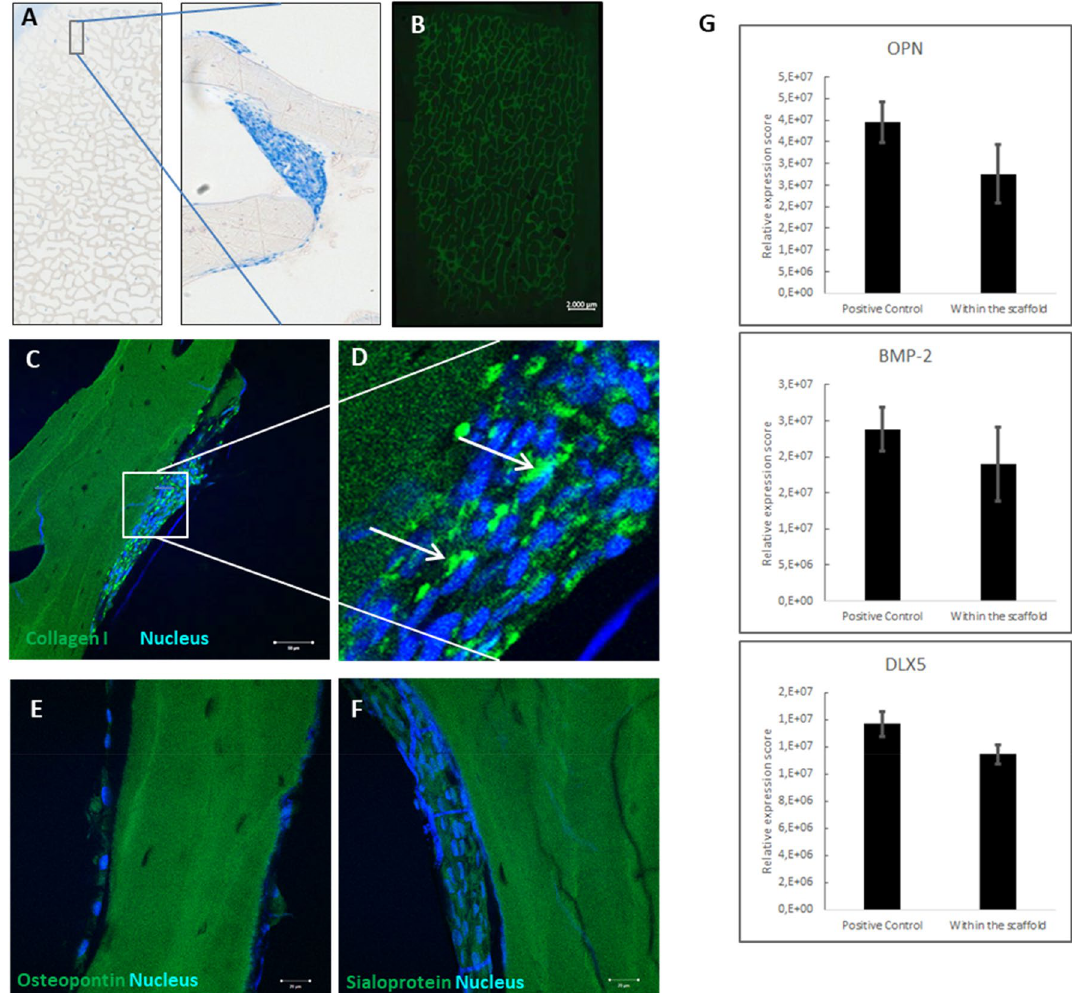
Figure 8. Histological analysis of scaffolds perfused with oscillating perfusion mode. Scaffold blocks were perfused in a bioreactor type2_enc+_osc with 0.5 × 10 6 cells/ml, followed by 14-day incubation in a roller culture. ( A ) Scaffolds were stained with Giemsa’s Azure-Eosin-Methylene Blue Solution and Toluidine Blue-Methylene Blue-Pyronine solution showing multi-layered stem cell accumulations extending over the surface and the pores of the bone graft substitute. ( B ) Autofluorescence image of the scaffold block representing background fluorescence visualized by fluorescence microscopy equipped with FITC filter set. Immunohistochemical staining of osteogenic differentiation markers (green) Collagen I ( C, D ), Osteopontin ( E ) and Bone Sialoprotein ( F ) counterstained with Hoechst (blue) to visualize cell nuclei by confocal LSM. White arrows represent newly expressed marker proteins by ASC. Collagen I is expressed in all stem cell layers as well as Osteopontin and Bone Sialoprotein, indicating differentiation of ASC into the osteogenic lineage (LSM 780, Carl Zeiss Microscopy GmbH). ( G ) Expression analysis of three osteogenic marker genes (i) osteopontin (OPN), also known as bone sialoprotein I, (ii) bone morphogenetic protein 2 (BMP-2), and (iii) the distal-less homeobox 5 gene (DLX-5). Notably, transcript levels of all three osteogenic differentiation genes do not differ significantly between the positive control (chemically differentiated ASCs) and the perfused cells within the